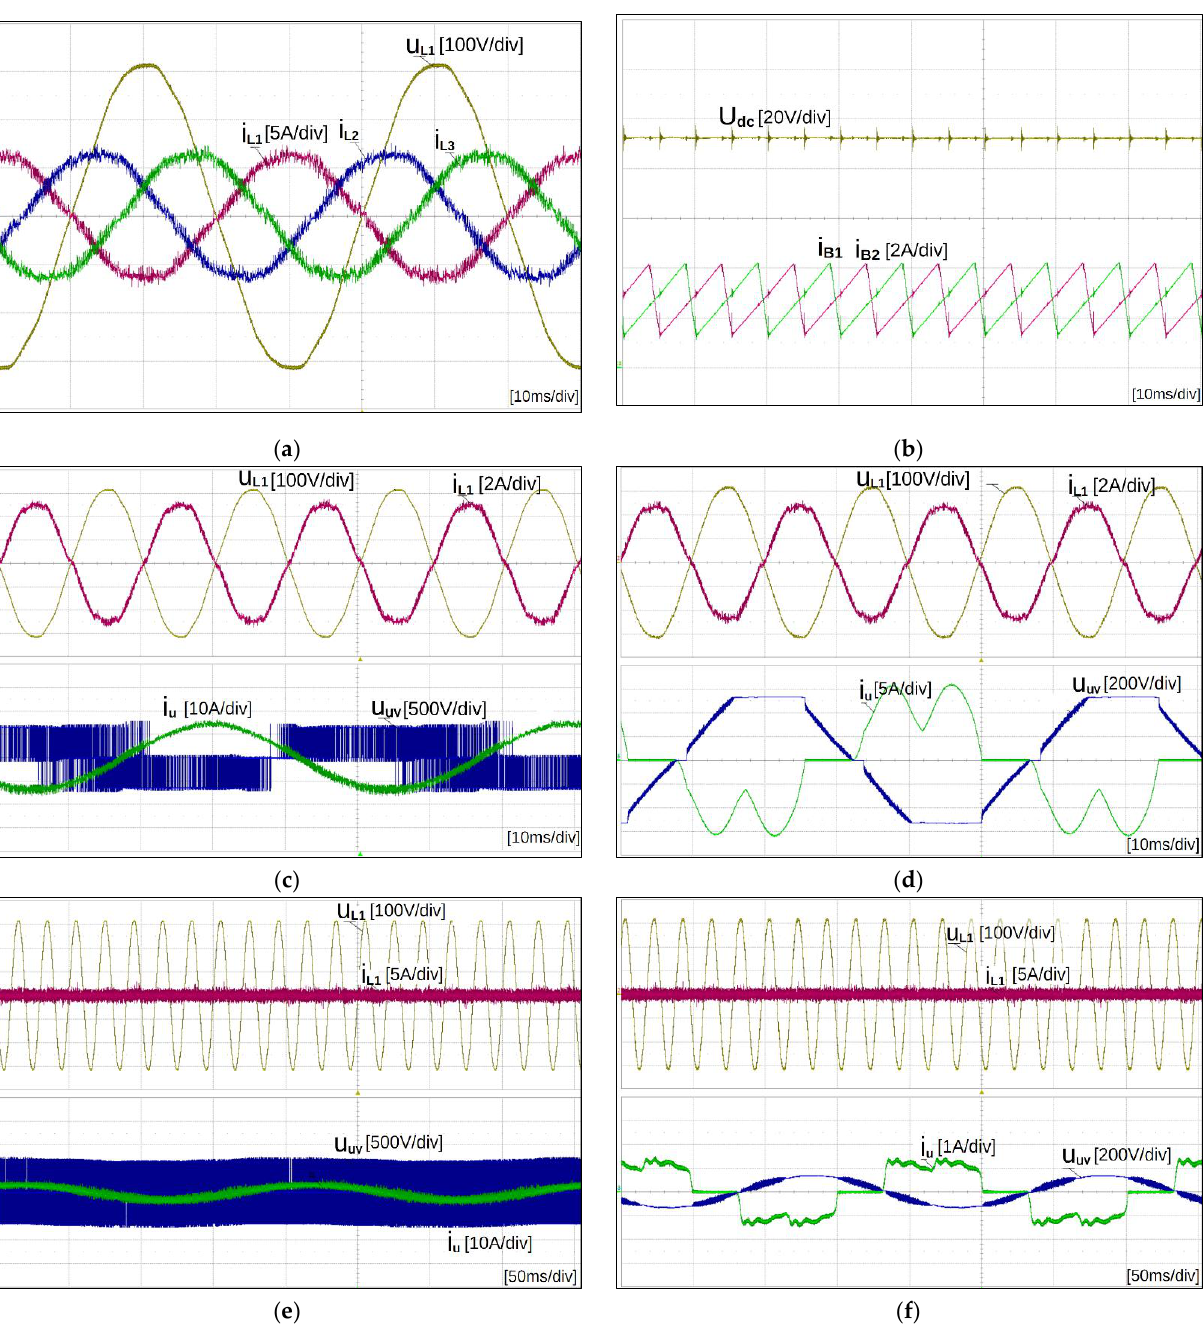
Figure 6. Oscillograms representing the operation of converters with T1 and T2 topologies: ( a ) the voltage and output currents of the AC/DC converter fed to the grid; ( b ) the input currents and input voltage of the DC/DC converter of the topology T2; ( c ) the current and output voltage of one phase of the grid converter and the current and phase-to-phase voltage of the generator — topology T1; ( d ) T2; ( e ) the current and phase-to-phase output voltage of the grid converter and the current and phase-to-phase voltage of the generator at zero power fed to the grid — topology T1, ( f ) T2.